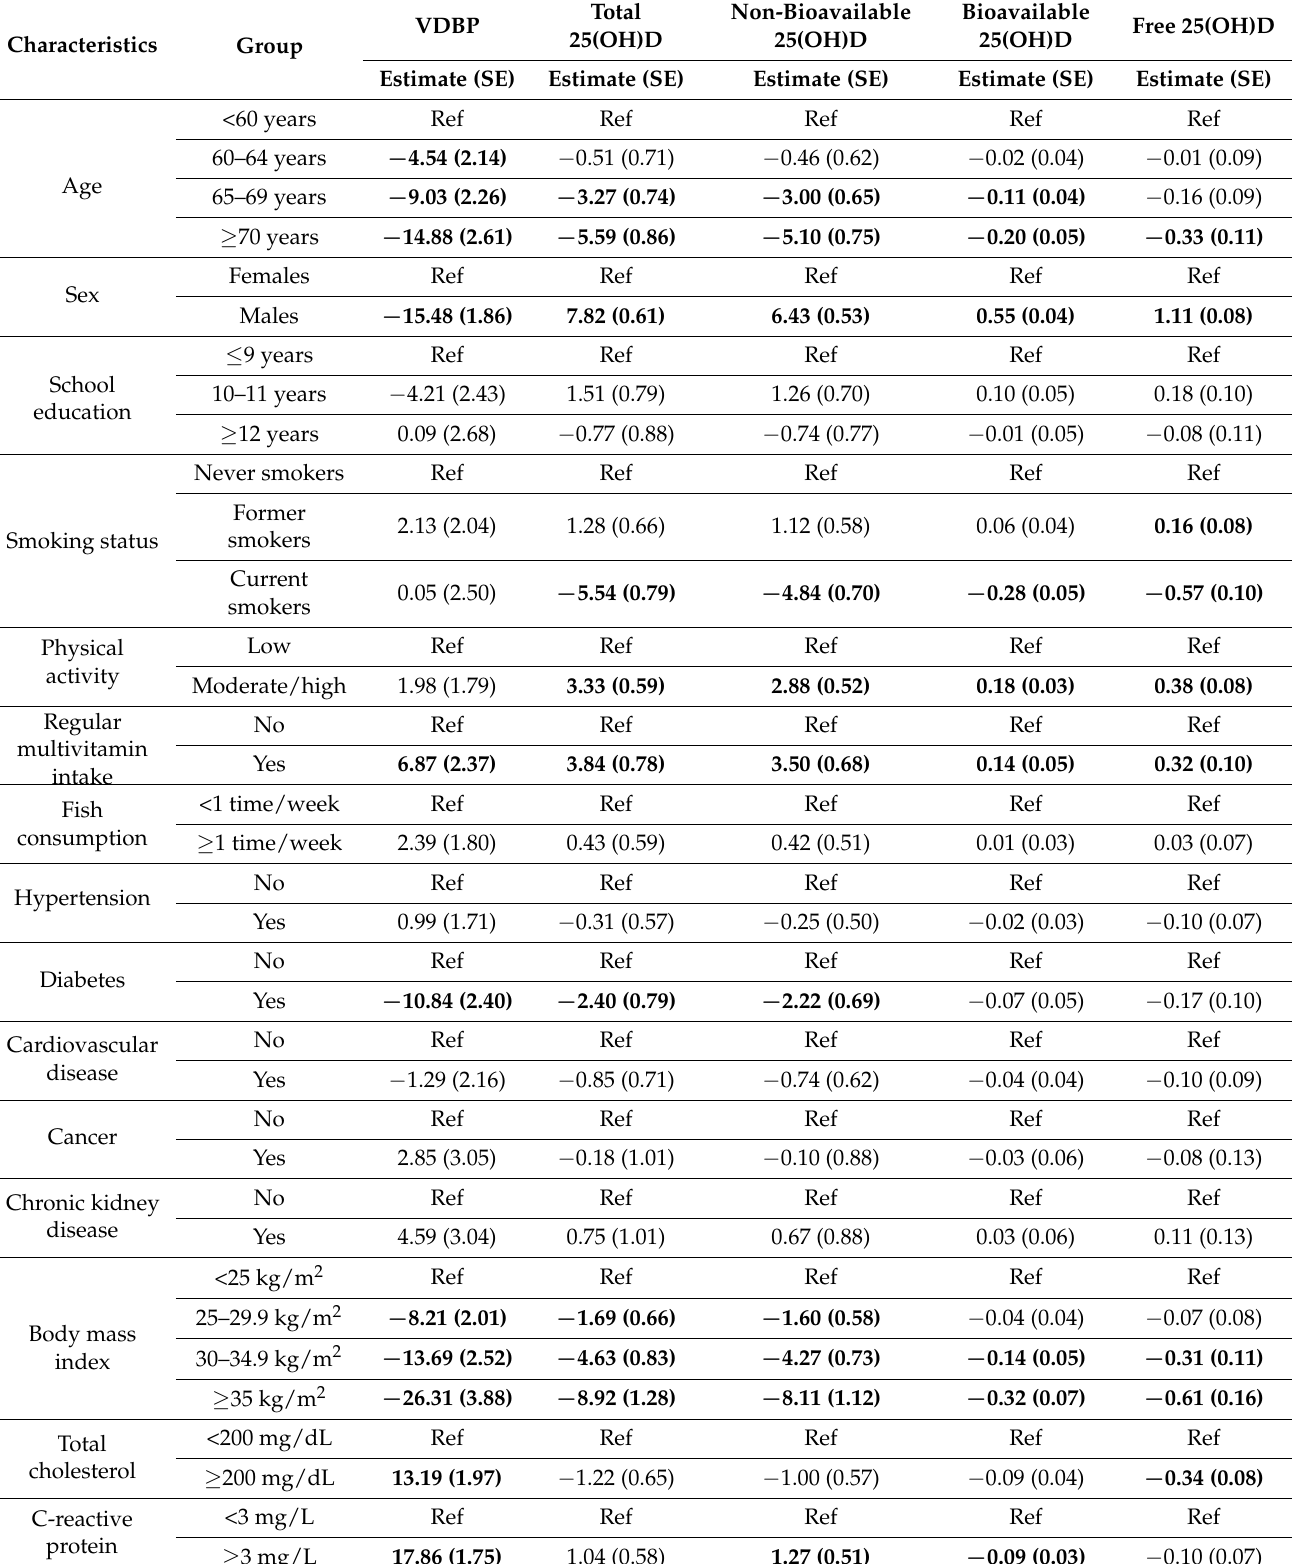
Table 3. Associations of various characteristics with VDBP, total, non-bioavailable, bioavailable, and free 25(OH)D concen- trations: results of multiple linear